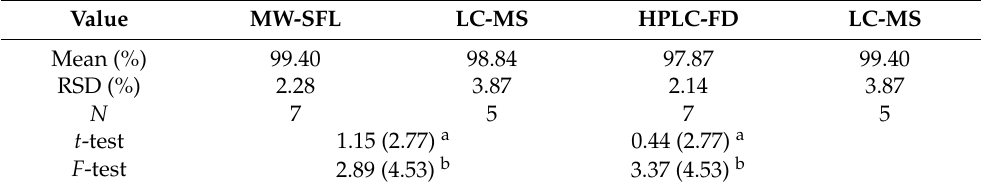
Table 6. The statistical analysis of the results obtained via the proposed MW-SFL and HPLC-FD methods and the reported LC-MS method for the analysis of ALC in spiked human urine